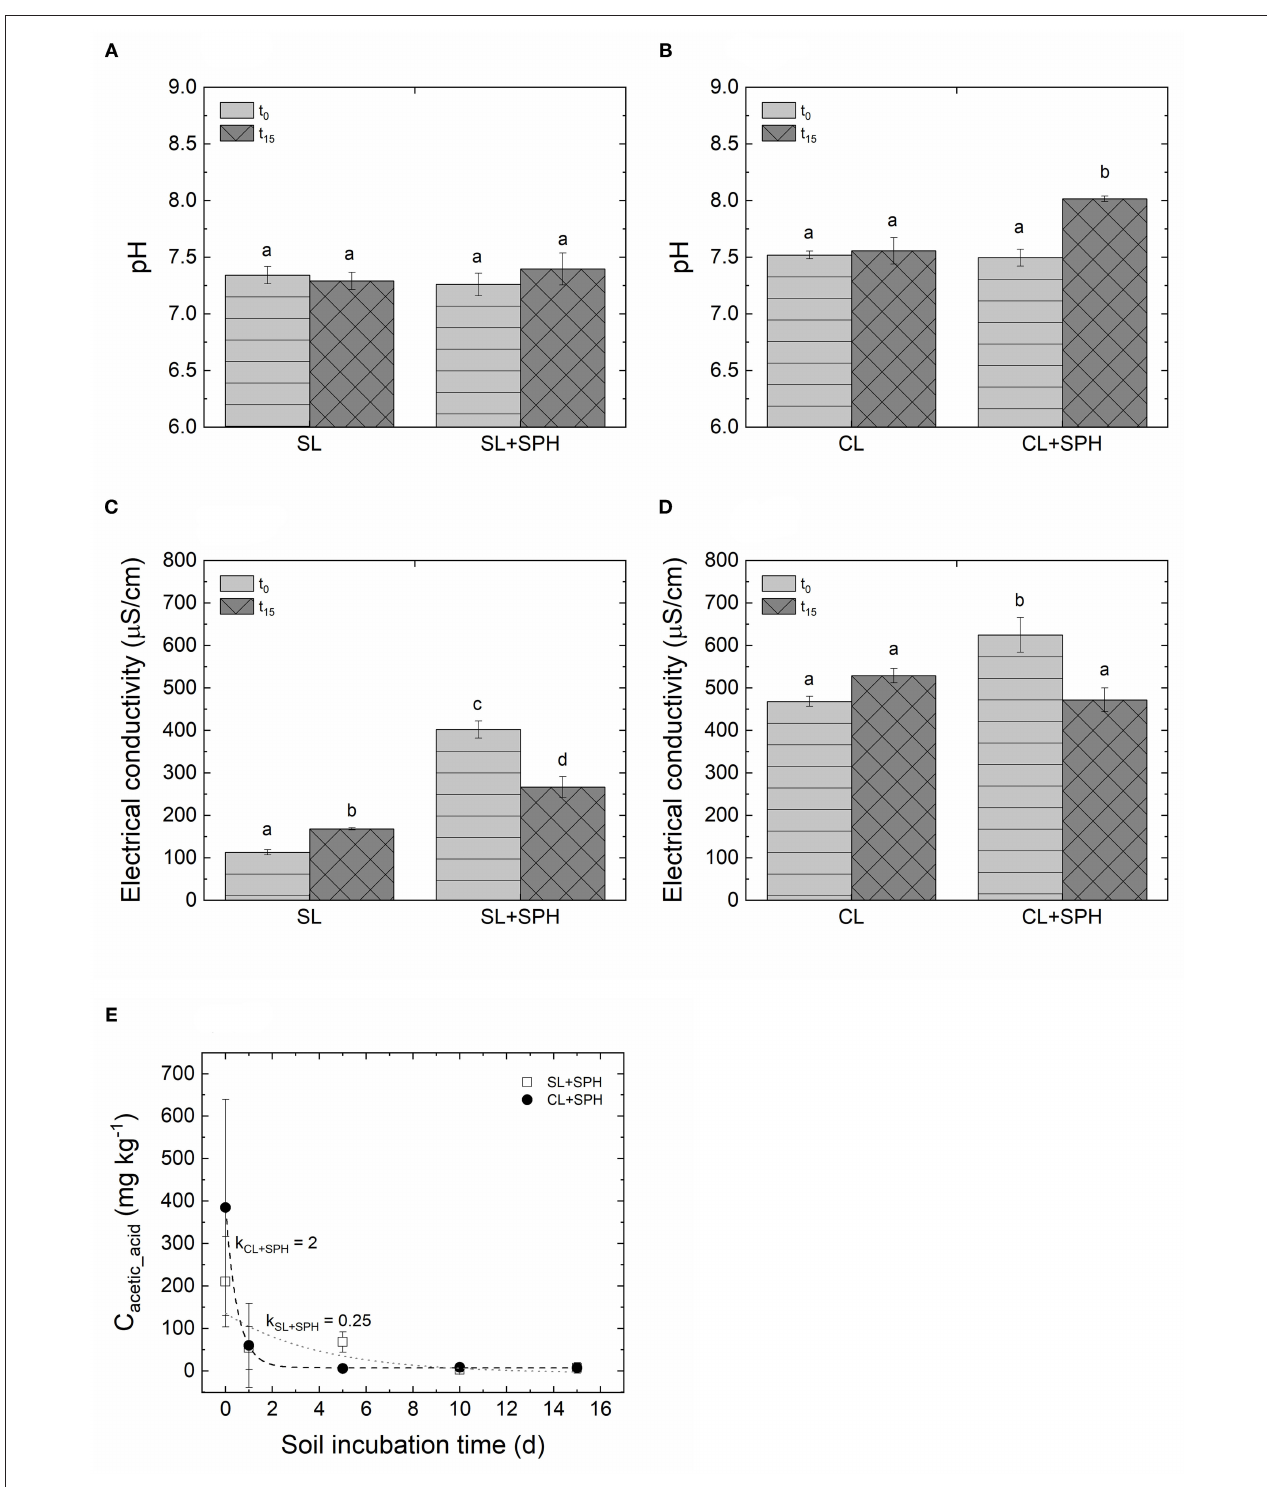
FIGURE 2 | (A) pH for sandy loam (SL), (B) pH for sandy clay loam (CL), (C) electrical conductivity (25 ◦ C) for SL, (D) electrical conductivity (25 ◦ C) for CL with (2% dw) and without amended spent pollinator hulls (SPH) under anaerobic conditions for initial (0 days, t 0 ) and final time (15 days, t 15 ). Different letters indicate significant differences ( p < 0.05) in a one-way ANOVA followed by a Tukey’s HSD post-hoc test. (E) Acetic acid concentration after anaerobic incubation measured for the time-points t 0 , t 1 , t 5 , t 10 , and t 15 and fitted with a 1st order decay model (dotted line: SL + SPH; dashed line: CL + SPH). Parameter k represents the decay constant. Bars represent standard deviations ( n = 3).